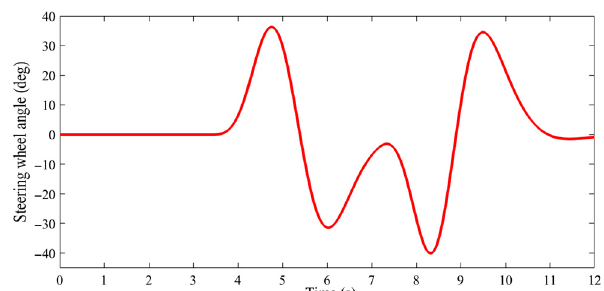
Figure 8 Angular curve of steering